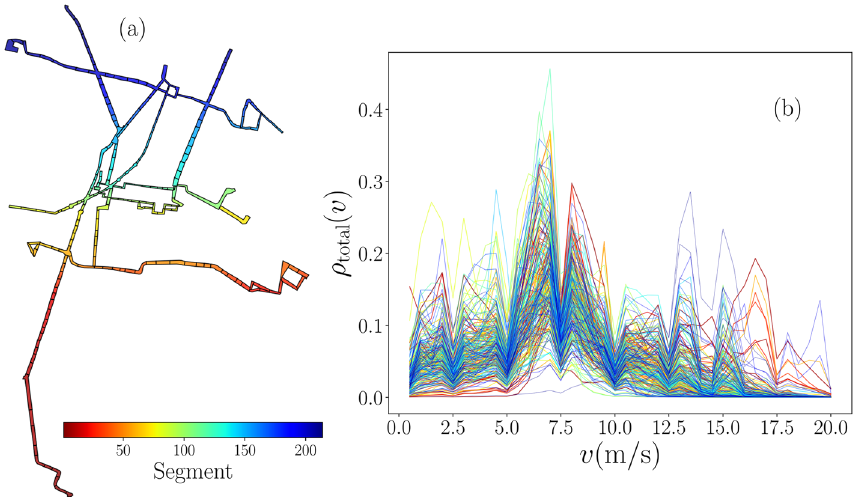
Figure 2. Activity of vehicles in segments of the system Metrobús in Mexico City. ( a ) Map with polygons associated to each of the N = 214 segments in the system. ( b ) Probability density ρ total ( v ) of the speed v of vehicles in each segment. The values ρ total ( v ) are obtained from bin counts in the interval 0 < v ≤ 20m / s with increments � v = 0.25m / s . Segments are sorted considering their geographical coordinates with a number codified in the color bar that applies for polygons in ( a ) and the respective ρ total ( v ) in ( b ). All figures were created using python 3.8 and the matplotlib (3.4.3) package (https:// matpl otlib. org). The map in panel ( a ) was created using the geopandas (0.10.2) package (https:// geopa ndas.